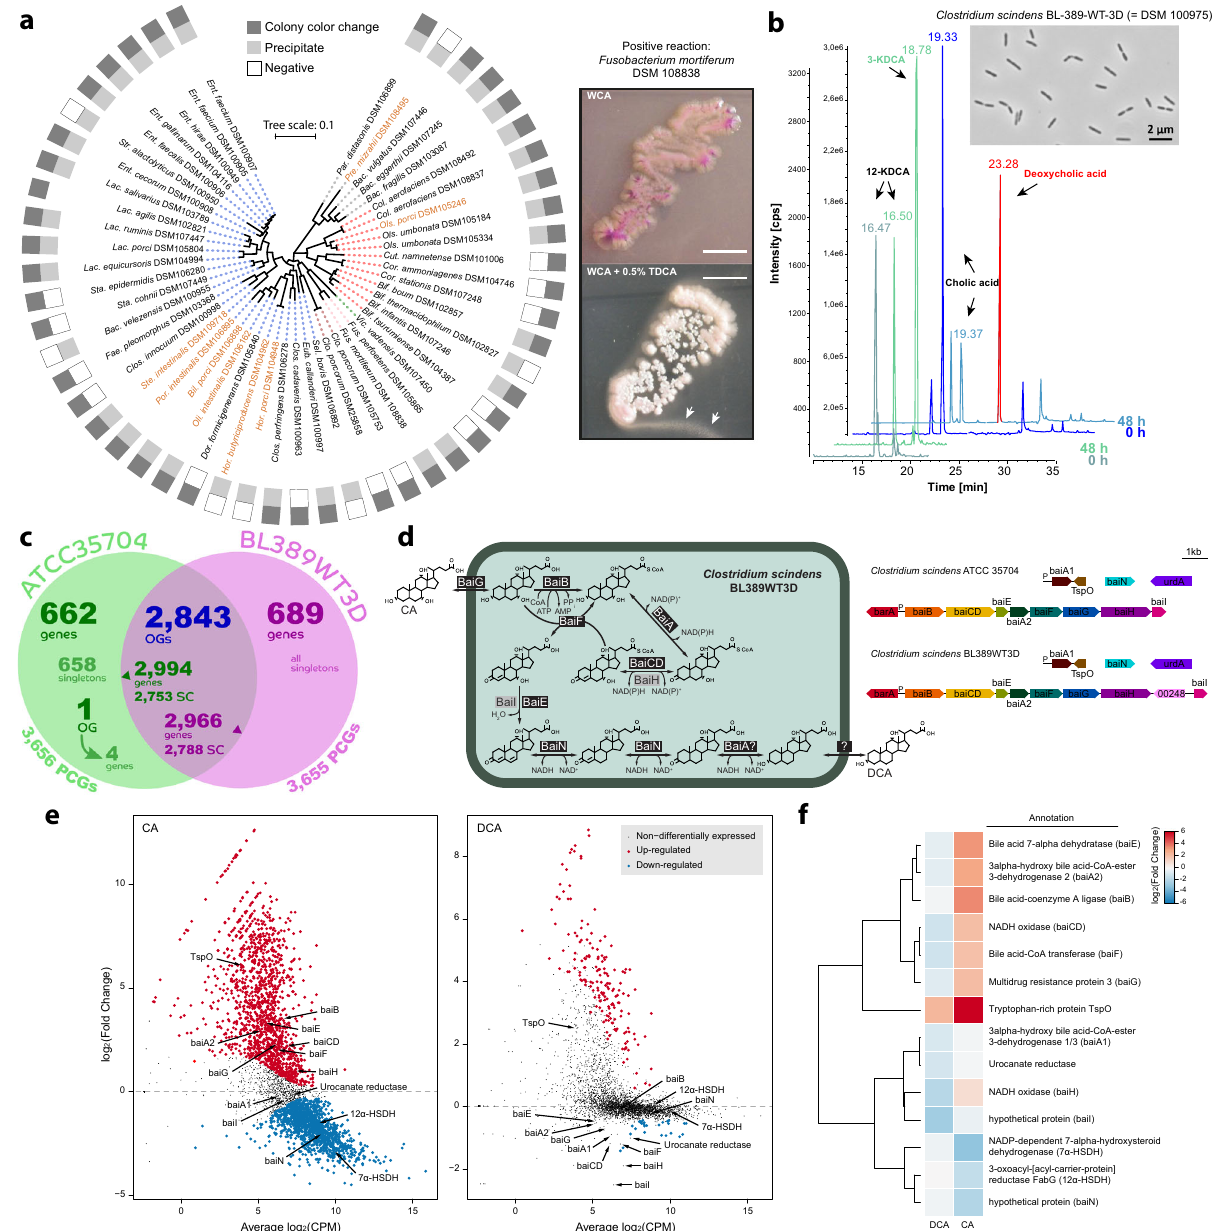
Fig. 6 Bile acids metabolism capacities and functional host-speci fi c traits. a Left: 16S rRNA gene-based phylogenetic tree showing the diversity of isolates able to deconjugate bile acids. Species (corresponding branches) are coloured according to phyla as in Fig. 1. Right: magni fi ed pictures of a culture of Fusobacterium mortiferum grown on plates (WCA, Wilkins – Chalgren-Anaerobe medium) without (top) or with (bottom) addition of 0.5% (w/v) tauro- conjugated deoxycholic acid (TDCA). Two criteria were considered as indicative for positive reaction: (i) whitening of the colonies; (ii) formation of a halo surrounding colonies (solid medium; white arrows in the picture) or precipitates visible at the bottom of the wells and jelli fi cation of the medium when grown as liquid cultures (not shown). The scale bars represent 5mm. b Chromatograms showing the conversion of cholic acid to deoxycholic acid by C. scindens DSM 100975. KDCA, ketodeoxycholci acid. The two chromatograms on top span the entire run time. The bottom ones are zoom-in sections (XIC: + MRM m/z 424.367/371.300 Da) until the indicated time to visualize the appearance of 3-KDCA. c Venn diagram of comparative genomic analysis between the human faecal isolate C. scindens ATCC 35704 and the pig isolate DSM 100975 ( = BL-389-WT-3D). SC single-copy, PCG protein-coding genes, OG orthologous group. d Gene organization of the bile acid-inducible ( bai ) genes in the two strains and overview of the bile acid 7- alpha -dehydroxylation biochemical pathway. e Scatterplots of average log 2 (CPM) vs. log 2 (fold-change) from duplicate 0.1 mM cholic acid (CA) or deoxycholic acid (DCA) induced cultures of C. scindens DSM 100975. Genes involved in bile acid metabolism are labelled. f Heat map of bile acid-metabolizing genes from CA- and DCA- induced transcriptomes. Genes included in e and f were differentially expressed ( + / − ) 0.58 log 2 (FC) with false discovery rate (FDR)<